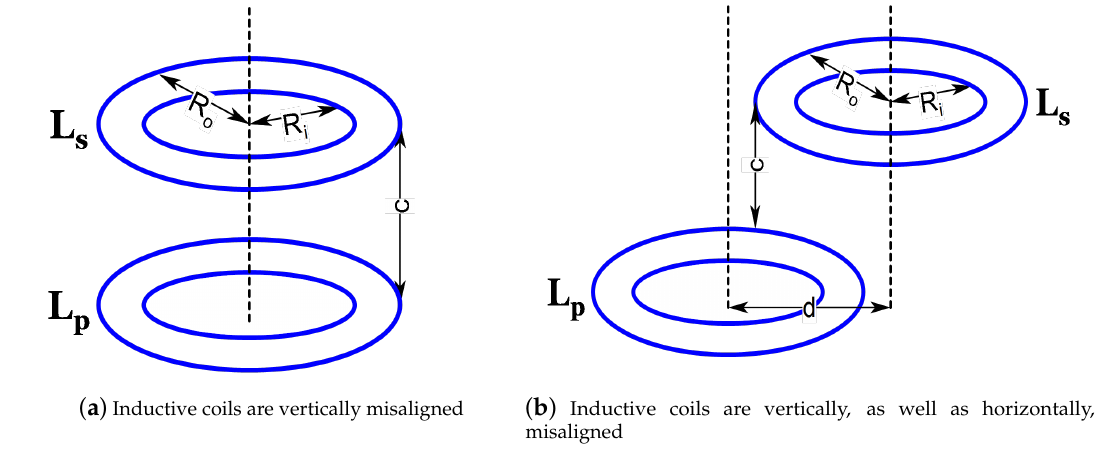
Figure 3. Misalignment of inductive